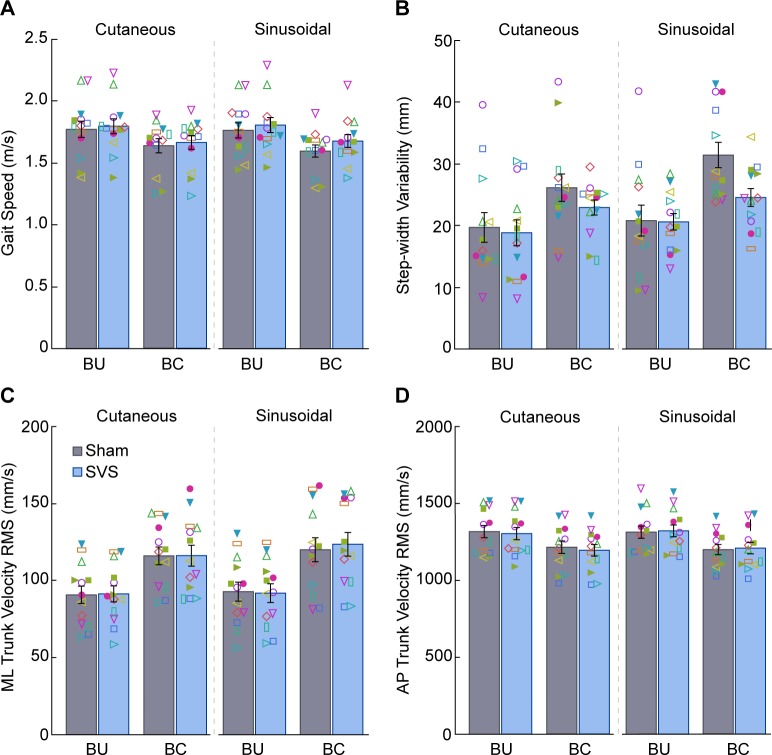
Results for the walking tasks.(A) Gait speed. (B) Step-width variability. (C) Medial-lateral (ML) trunk velocity root mean square (RMS). (D) Anterior-posterior (AP) trunk velocity RMS. Data are mean ± SE. Individual participant data are superimposed. Gait speed increased and step-width variability decreased with SVS (stimulation condition main effect, p < 0.05). Details of the main effects of threshold technique, balance condition, and stimulation condition are reported in Table 3.